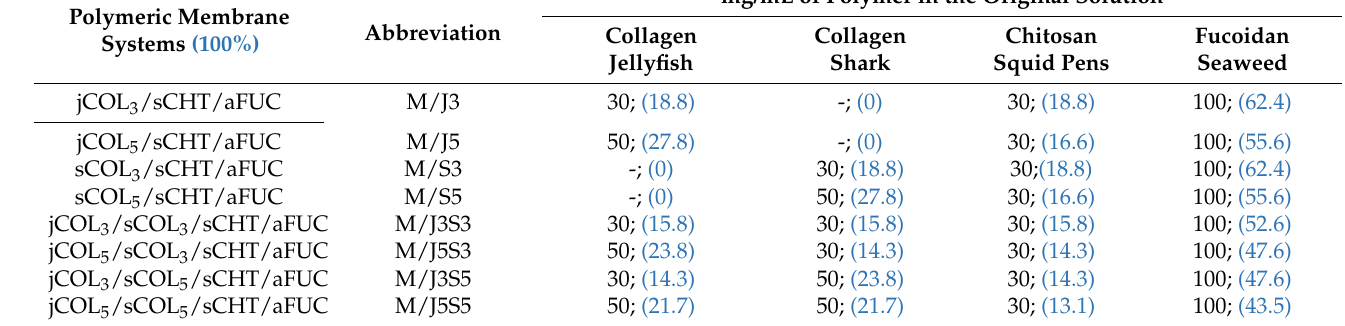
Table 2. Membrane composition prepared by blending equal volumes of different marine origin biopolymer solutions (ratio of each biopolymer in the original solution and their percentage after biomaterial